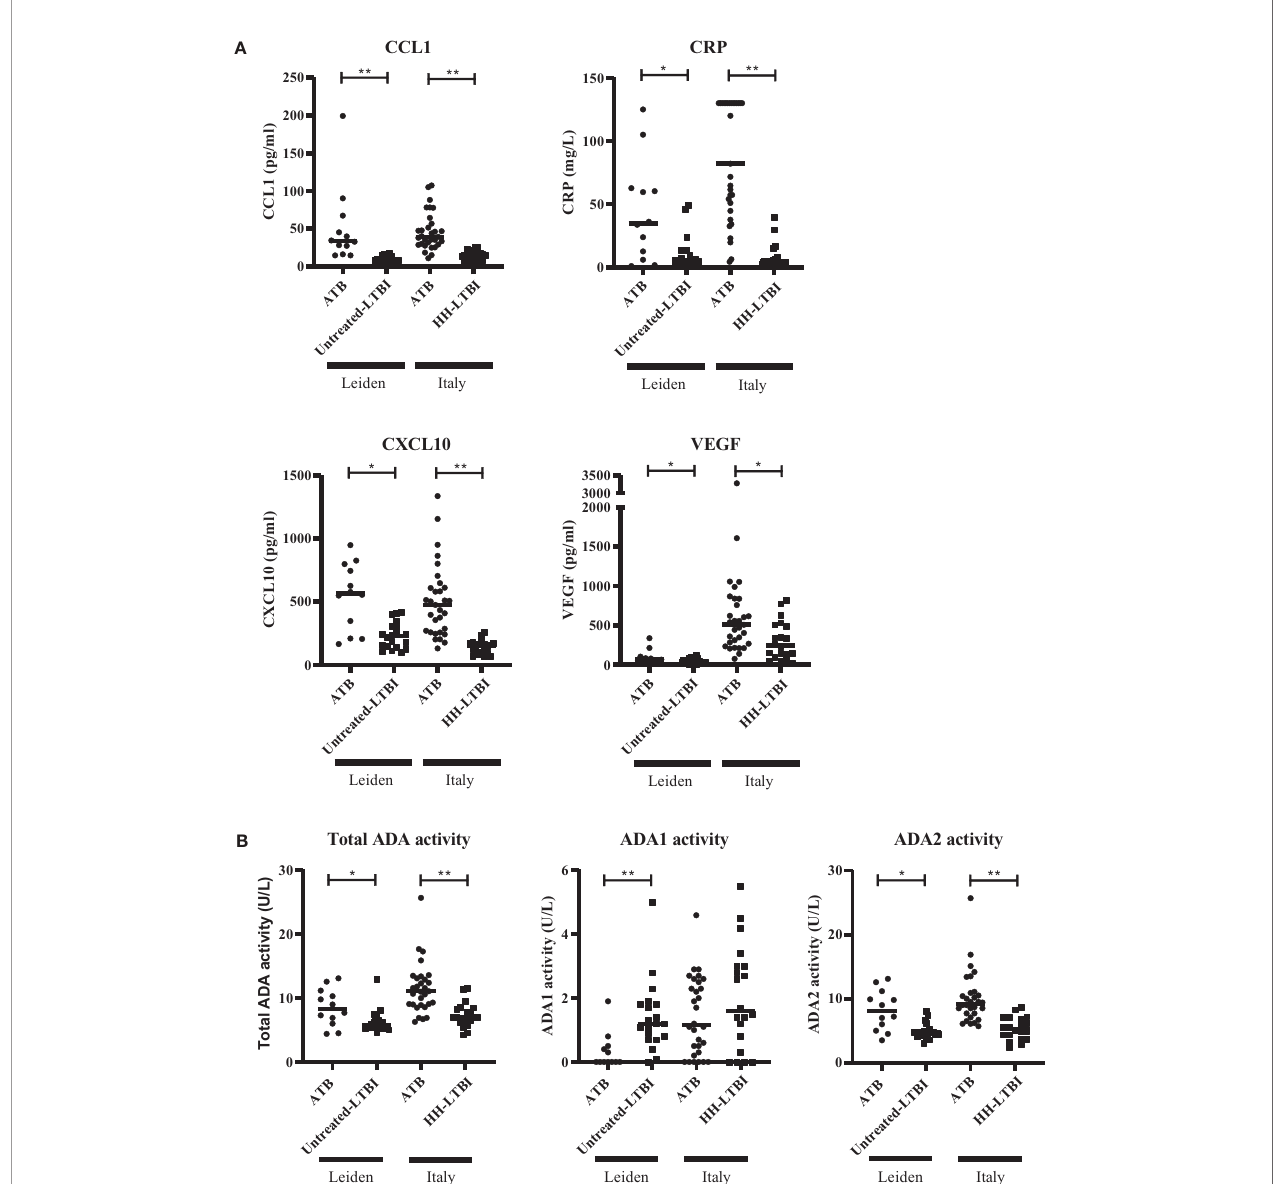
FIGURE 4 | Serum levels of CCL1, CRP, CXCL10, VEGF, and ADA activity differently expressed in patients with ATB compared to untreated LTBI individuals in two independent cohorts. Serum levels of CCL1, CRP, CXCL10, VEGF (A) , and ADA activity (B) are shown. The two patient groups per cohort were compared for each marker using Mann – Whitney U tests. Filled dots represent patients with ATB, and fi lled squares represent individuals with untreated LTBI or households of ATB patients diagnosed with untreated LTBI/untreated HH-LTBI. Median concentration is depicted with horizontal line in each group. ADA, adenosine deaminase; ATB, active tuberculosis; CCL1, C-C motif chemokine ligand 1; CRP, C-reactive protein; CXCL10, C-X-C motif chemokine ligand 10; LTBI, latent tuberculosis infection; VEGF, vascular endothelial growth factor. * 0.001 < p < 0.05, ** p <